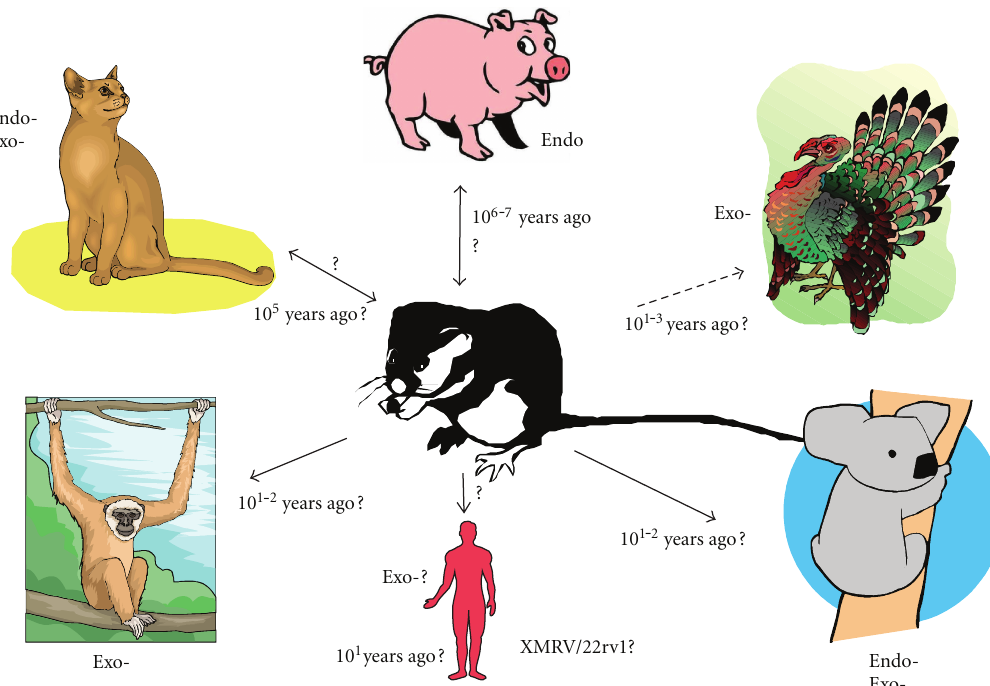
Figure 5: MLLVs have spread among vertebrates in recent evolutionary time. The approximate time estimates to the last common MLLV progenitor are based on references given in the text, and on the phylogenetic analysis of Figure 1. Some gibbon apes in captivity have gibbon ape leukemia virus (GaLV). Koalas have recently been infected with koala retrovirus (KoRV). More distant relatives of the murine MLVs occur in pigs and cats. Porcine MLLV ERVs (PERVs) are MLLVs but the interspecies transmission routes are uncertain. Cats have several endogenous and exogenous MLLVs, including feline leukemia virus (FeLV). Birds have recently been infected with reticuloendotheliosis virus (REV). REV is not strictly an MLLV, but is a gammaretrovirus highly related to MLLVs. Its origin is uncertain, but its closest relatives are the ERV-T-like proviruses from opossum and primates. Humans may also recently have been infected with murine MLLVs, namely XMRV, although there are now indications that this is a laboratory contamination with the 22Rv1 virus. Endo-: endogenous retrovirus. Exo-: exogenous